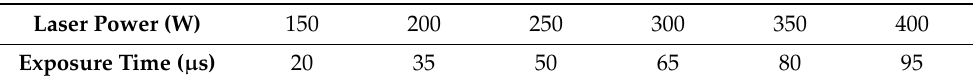
Table 3. Process parameters used to determinate the optimized ones.